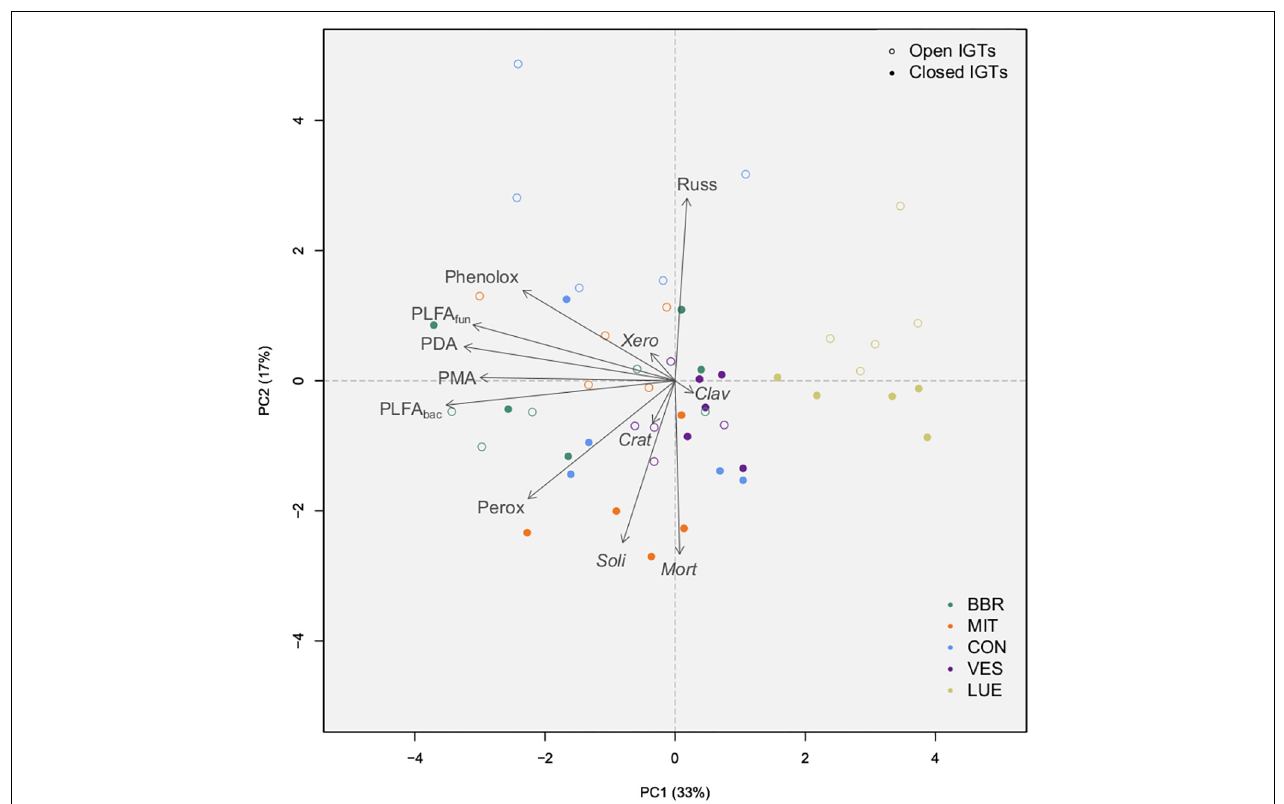
FIGURE 6 | Results of principal component analysis of absolute amounts of PLFAs (sum of 15:0, i15:0, a15:0, i16:0, i17:0, cy17:0, cy19:0, 16:1 ω 5 = bacterial PLFA, 18:2 ω 6,9 = fungal PLFA), absolute number of OTUs from the most abundant EM and SAP fungal genera, and absolute amount of enzyme activity groups by treatment (open IGTs, closed IGTs) and forest [Bad Brückenau (BBR), Mitterfels (MIT), Vessertal (VES), Conventwald (CON) and Lüss (LUE)]. Clav , Clavulina ; Crat , Craterellus ; Mort , Mortierella ; PDA, Phosphodieserase activity; Perox, Peroxidase activity; Phenolox, Phenoloxidase activity; PLFA bac , bacterial PLFA; PLFA fun , fungal PLFA; PMA, Phosphomonoesterase activity; Russ , Russula ; Soli , Solicoccozyma ; Xero, Xeromellus